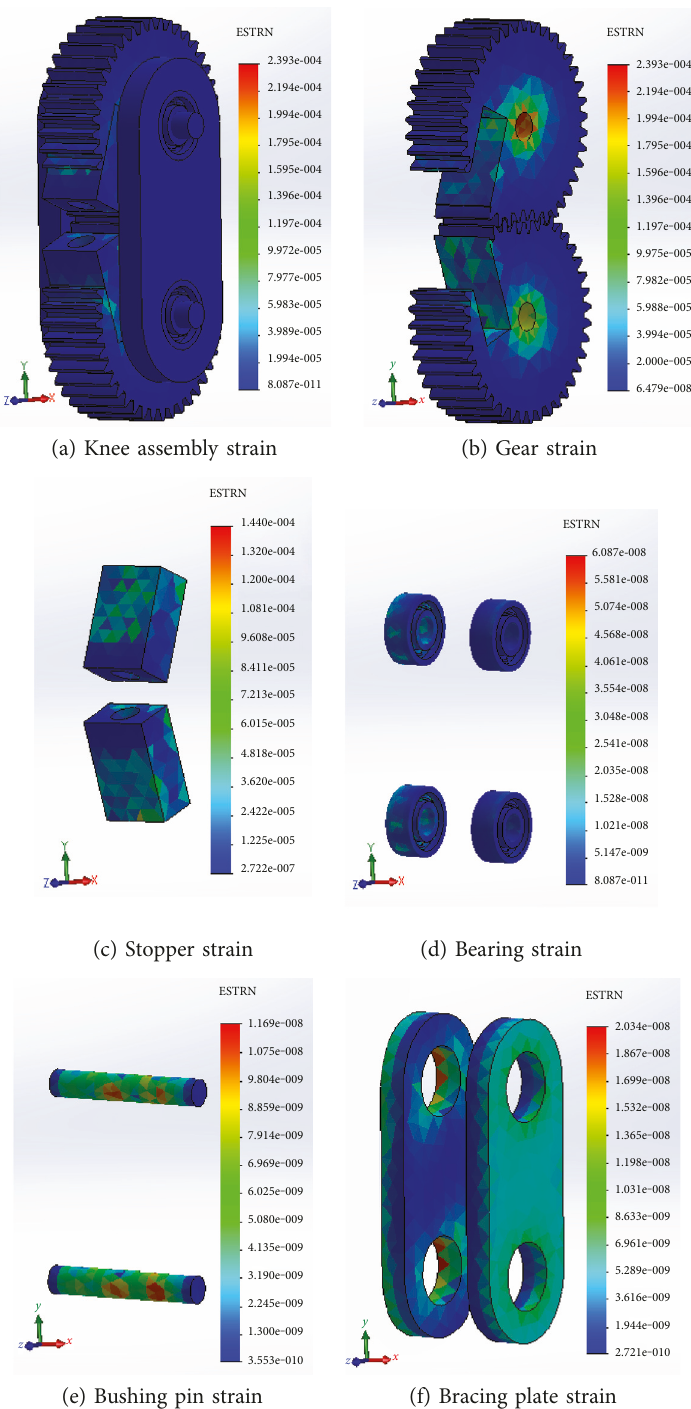
Figure 9: Strain analysis of the knee joint